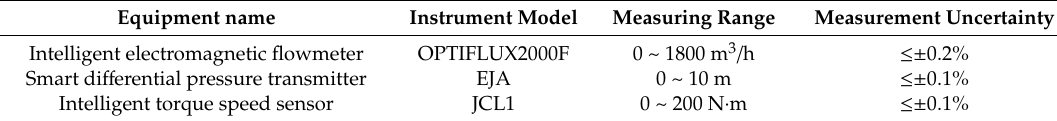
Figure 4. Photo of the axial flow pump device. Table 2. Basic parameters of test equipment.